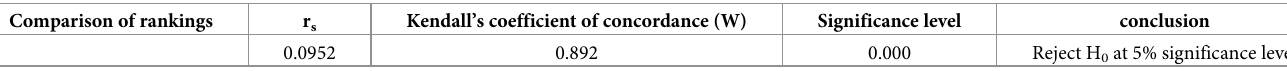
Shanghai residents’ awareness of housing safety are reliable, and the data from this question- naire are reliable and can be analyzed in the next step.